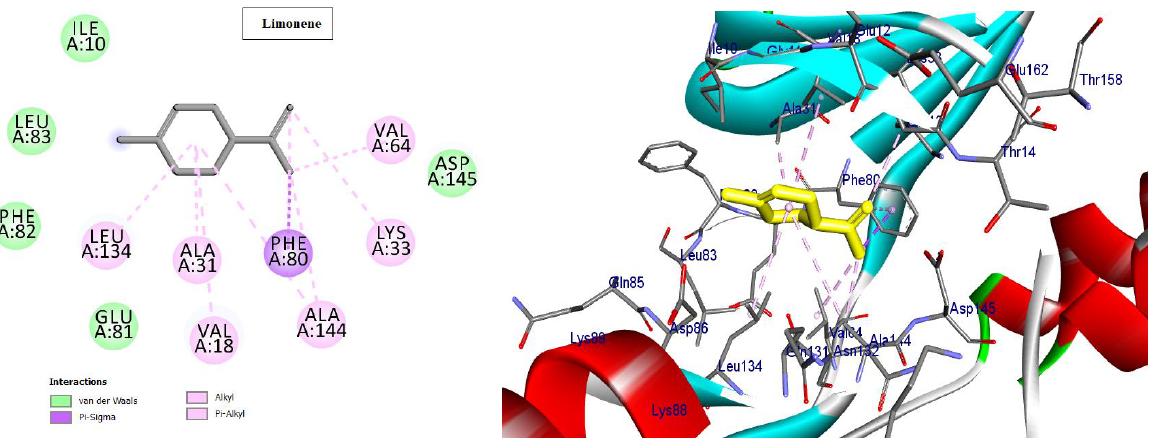
Figure 3. Two-dimensional and three-dimensional images of limonene docked into the ATP binding site CDK-2 enzyme.